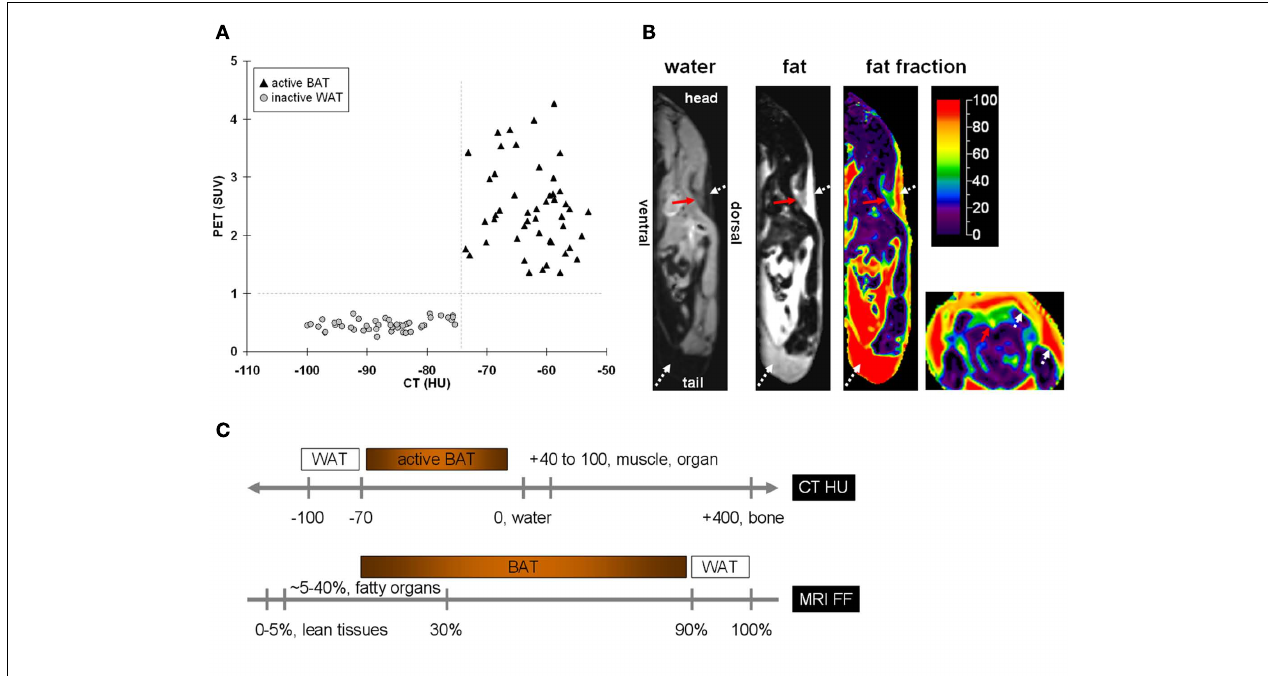
of a mouse. Shown additionally is the corresponding fat fraction (FF) map, on a color scale from 0 to 100%. Illustrated to the far right is the fat fraction map in the axial plane from the same animal.The red arrows point to the triangular/trapezoidal interscapular BAT depot.The white dotted arrows denoteWAT. Note that BAT has a much lower fat fraction thanWAT, caused by BAT’s greater water and lower fat content, which can be observed by the opposing grayscale contrast differences in the water and fat images, respectively. (C) A schematic of approximate BAT andWAT signal contrasts based on CT HU and MRI